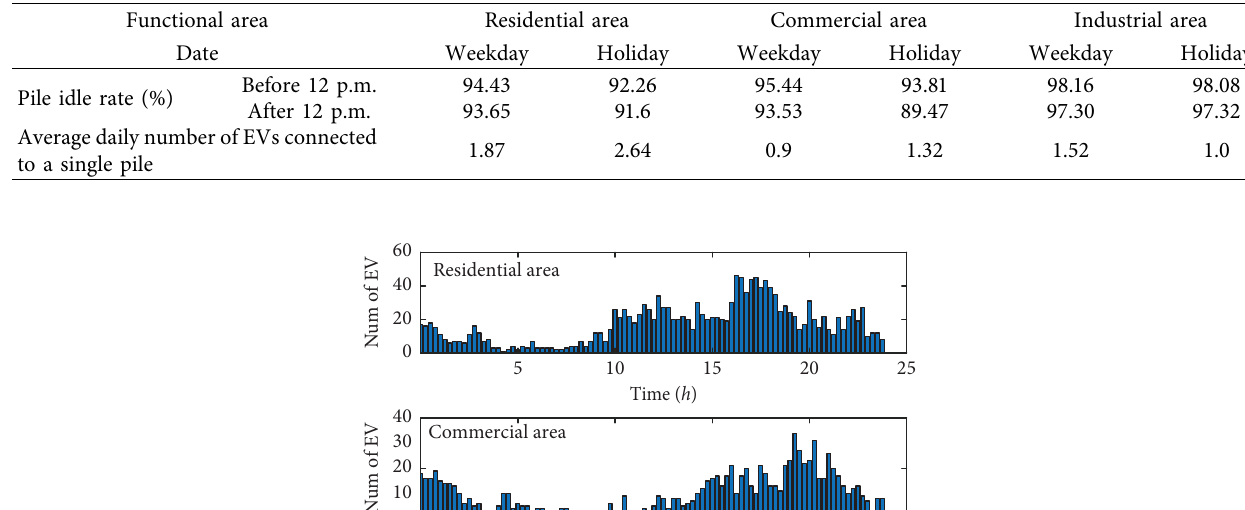
Table 1: Pile idle rate and average daily number of EVs connected to individual piles.